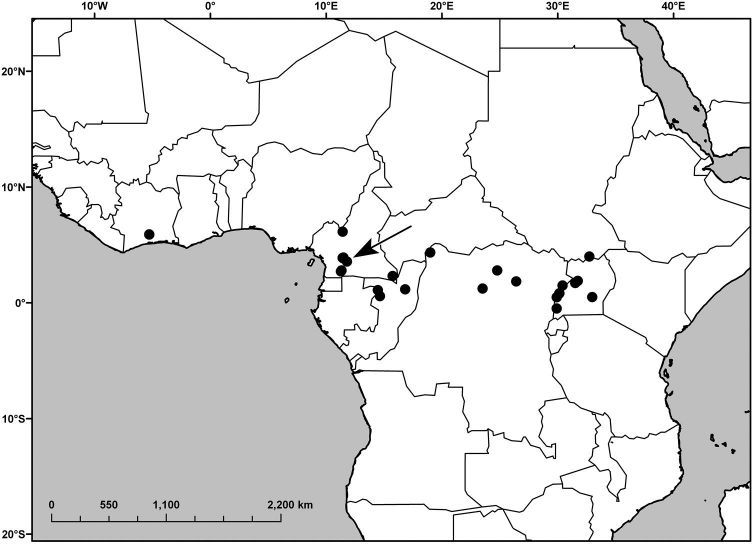
Distribution of Polyspatha oligospatha Faden, sp. nov. The arrow indicates the location of the collection Letouzey 11465, which is atypcial for the species (see text).